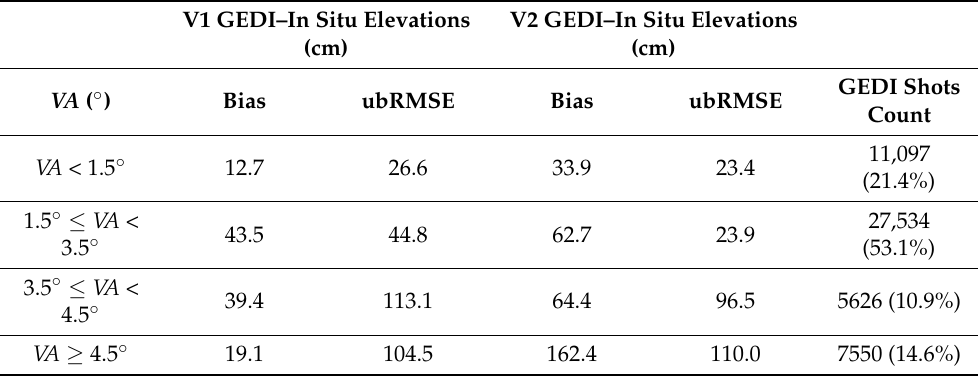
Figure 9. Unbiased root mean squared error of GEDI elevations (ubRMSE) as a function of GEDI’s viewing angle ( VA ). Table 5. Summary statistics of the difference between GEDI and in situ elevations according to the four classes of the GEDI’s viewing angle ( VA